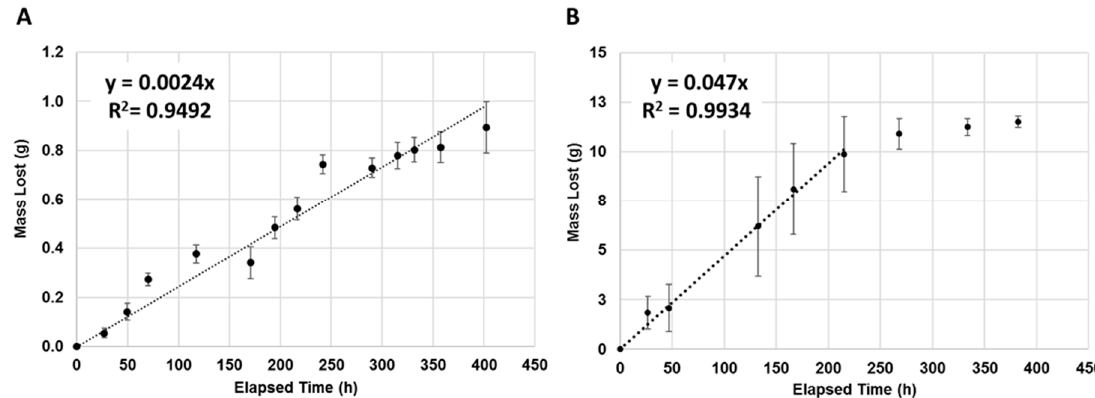
Figure 2. Release of geraniol and 1-methylpiperazine (1-MP) from passive wick and reservoir devices. Regression analyses of the release rate of ( A ) geraniol and ( B ) 1-MP showed zero order release (R 2 = 0.9492 and 0.9934, respectively). Regression analyses were calculated over the first 400 and 215 h, respectively. Samples were measured within a controlled environment: 32 °C and 70% relative humidity.